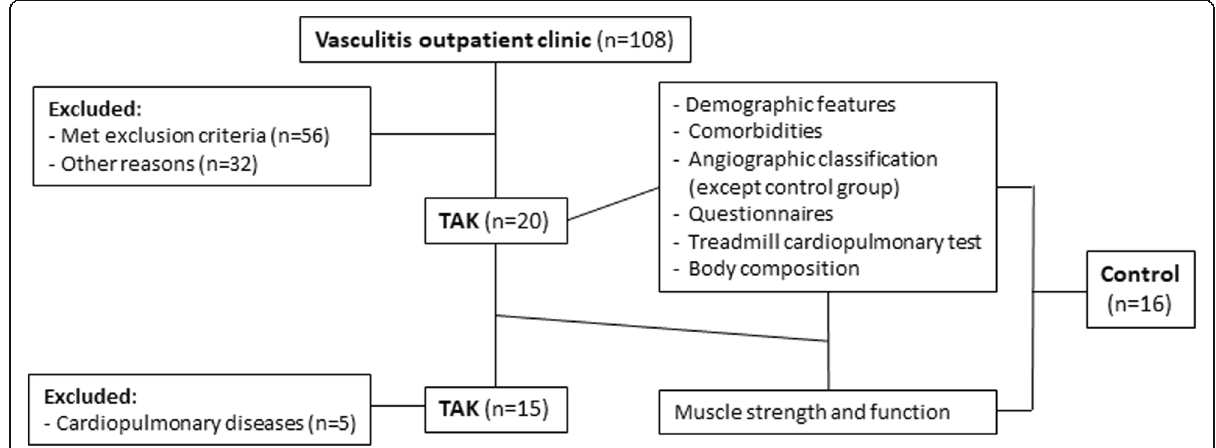
Fig. 1 Study flowchart. Legends: Control group; TAK: Takayasu arteritis